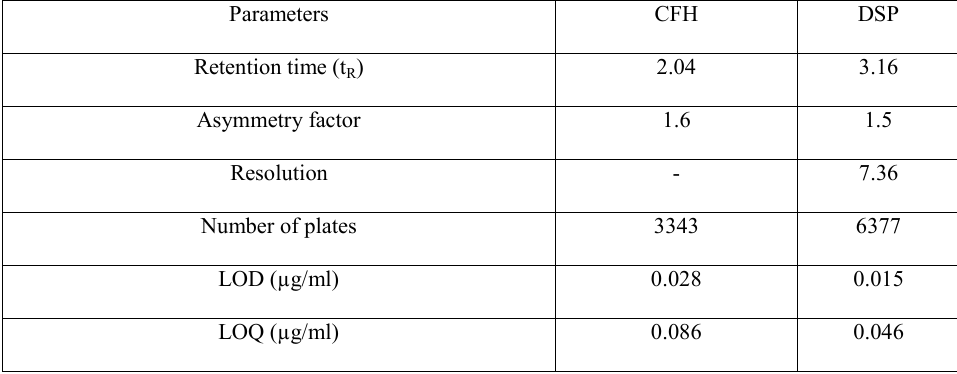
Table 4. System suitability parameters